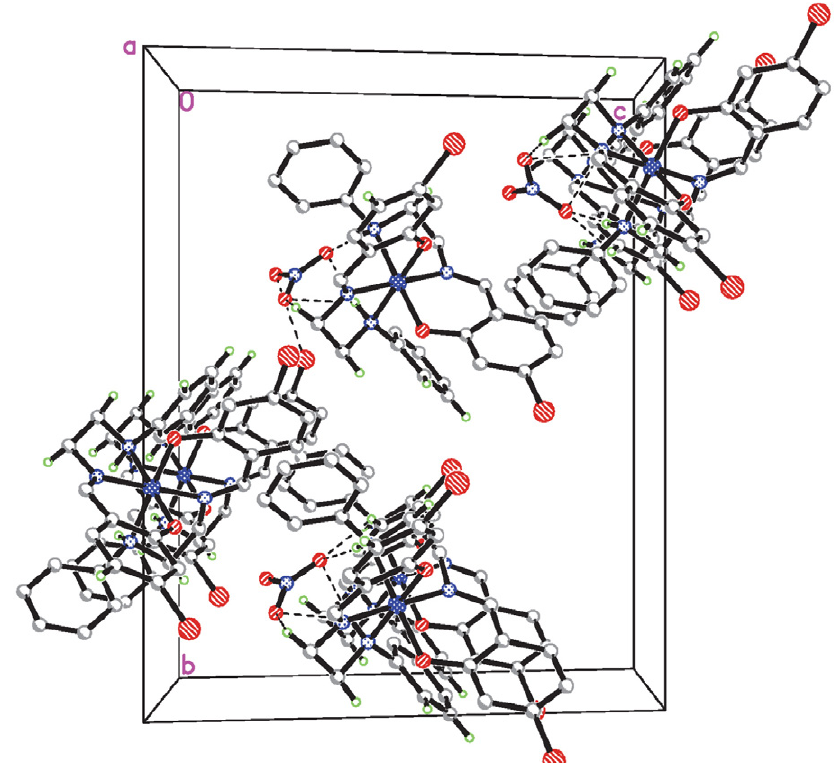
Fig. 3. Molecular packing diagram of complex 1 , viewed along the a axis. Hydrogen bonds are drawn as dashed lines.